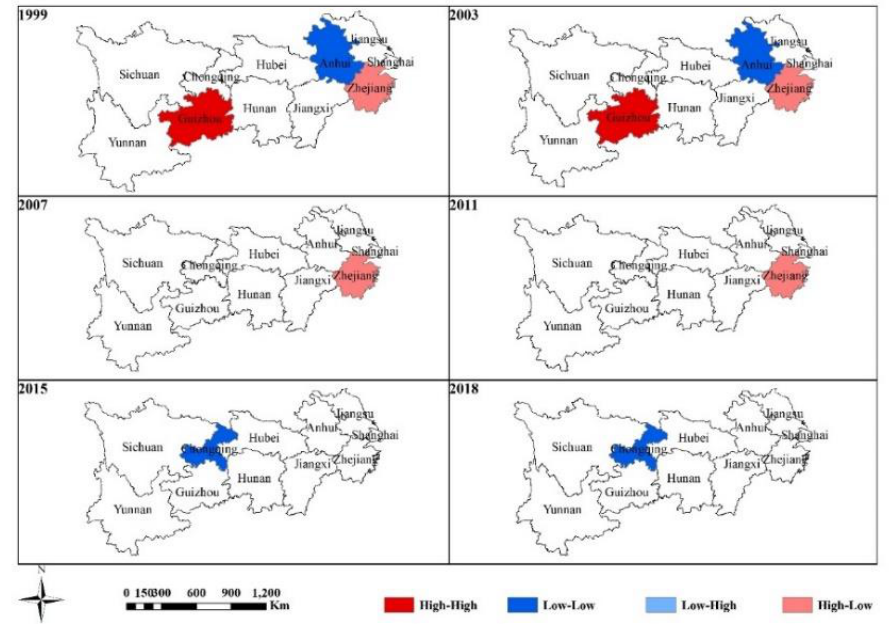
Figure 7. The spatial heterogeneity of the coupling system in 11 provinces from 1999 to 2018. In the first stage, the aggregate type was mainly positive autocorrelation, and it was relatively stable. The high-high type was Guizhou, indicating that Guizhou and its surrounding area have strong synergetic development capability. The low-low type was Anhui, indicating that the synergetic development capability among Anhui and its surrounding area is relatively low. There was no low-high type. The high-low type was Zhejiang, indicating that Zhejiang’s synergetic development capability is far greater than that of the surrounding regions. In the second stage, there is only the high-low type (Zhejiang), which indicates that Zhejiang’s synergetic development capability is still relatively strong and far greater than that of the neighboring regions. In the third stage, only the low-low type (Chongqing) indicates that the synergetic development capability of Chongqing and surrounding provinces is relatively